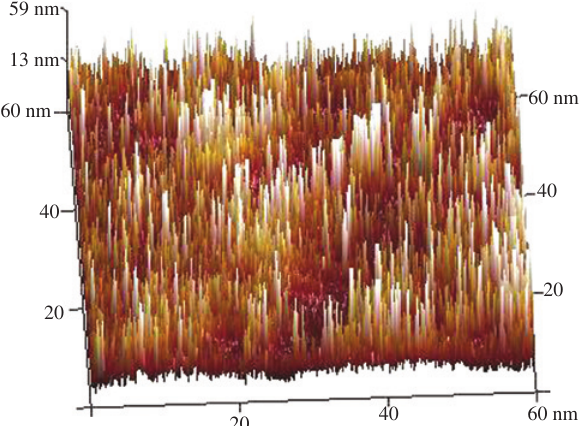
Figure 11: AFM three-dimensional images of nanoparticles doped PVA